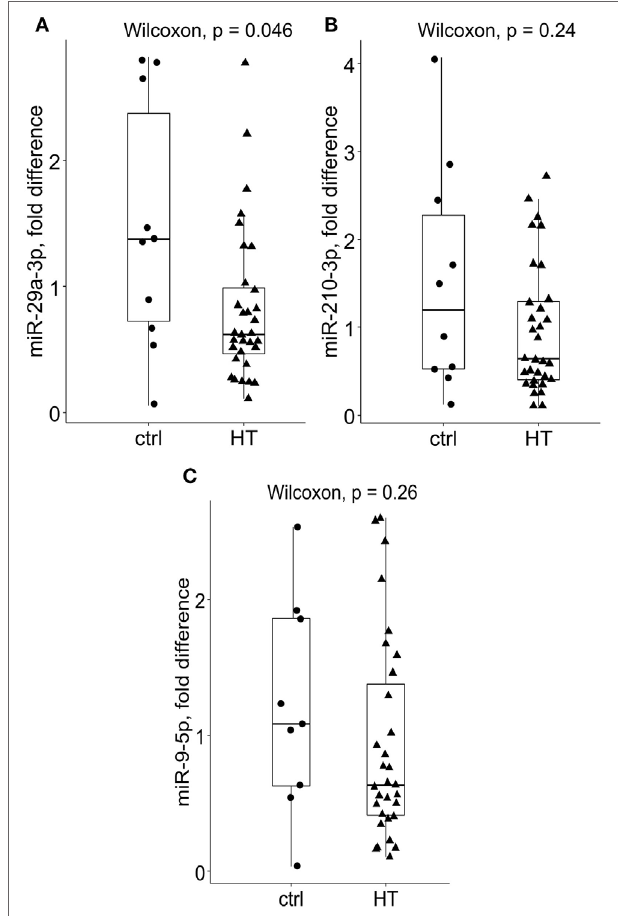
FigUre 1 | Relative expression levels of miR-29a-3p, miR-210-3p, and miR-9-5p in Hashimoto’s thyroiditis (HT) patients and healthy controls. Compared to controls, (a) miR-29a-3p levels were significantly reduced in bulk peripheral blood T cells of HT patients [HT ( n = 32), P = 0.046, Wilcoxon test, Bonferroni–Dunn’s post hoc comparison]. A non-significant decrease in (B) miR-210-3p levels was noted in HT vs control comparisons (HT vs controls; 0.64 vs 1.2, P = 0.24). Conversely, no difference in (c) miR-9-5p expression levels was found across the studied groups. Transcriptional changes were measured by RT-qPCR and normalized against U6snRNA. Within each box, the horizontal line represents the median value, and the first and third quartiles are the ends of the box. The whiskers extend to 1.5 × (interquartile